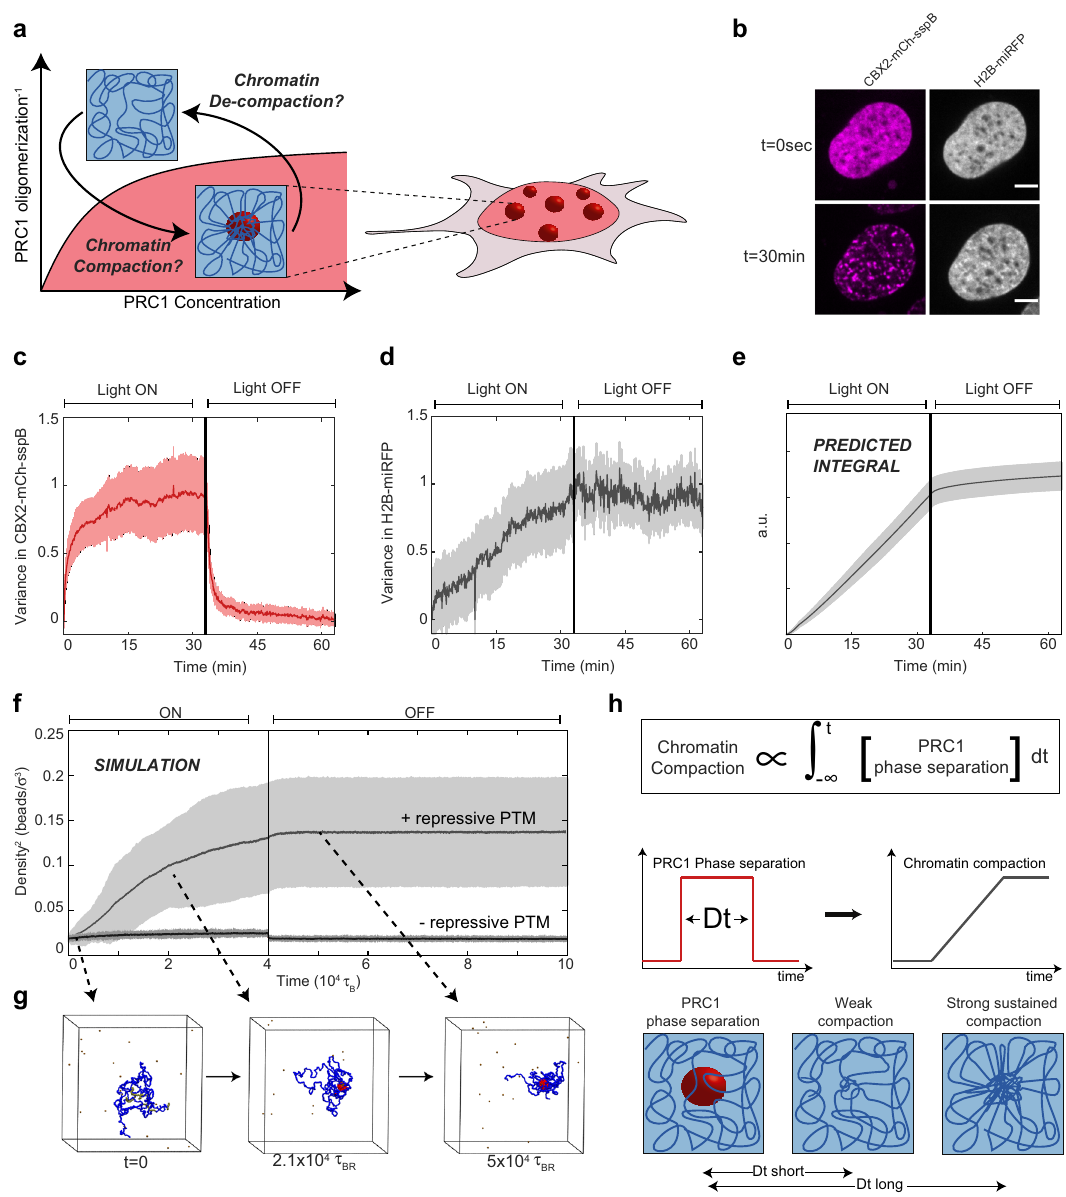
Fig. 5 PRC1 condensates lead to chromatin compaction. a Schematic of compaction experiment. After inducing condensate formation, chromatin compaction is examined and tested to determine whether compaction remains after deactivation. b CBX2-Corelet cell with H2B-miRFP670 before ( t = 0) and after activation (30 min). Scale bar is 5 µ m. c The normalized variance in the CBX2 signal increases rapidly as condensates form and decreases rapidly upon deactivation, as condensates dissolve. Data are presented as mean + / − SD, n = 10 cells. d The normalized variance in the H2B-miRFP670 signal increases gradually over time, and the high variance remains after deactivation, indicating sustained compaction. Error band represents mean + / − SD. e Integral of the CBX2 variance, showing that compaction sums over the prior history of CBX2 phase separation. Error band represents mean + / − SD. f Result of molecular dynamics simulation: chromatin bead density over time. Vertical line indicates time point at which proteins no longer bind chromatin. Error band represents mean + / − SD. g Snapshot images from molecular dynamics simulation. The chromatin chain in blue, with H3K27me3 patches in yellow, proteins in brown, and H2AK119Ub chromatin beads in red. h Long durations of prior PRC1 phase separation can lead to strong sustained chromatin compaction, even in the absence of sustained PRC1 phase